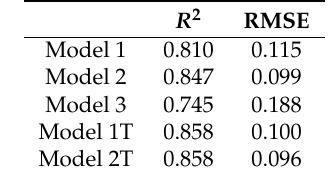
Table 2. Model performance with/without Twitter data. Table shows R 2 (coefficient of determination) and root mean squared error (RMSE) for Models 1, 2, 3, 1T and 2T. All scores are averaged from leave-one-out validation tests across all 11 pollen monitoring stations. R